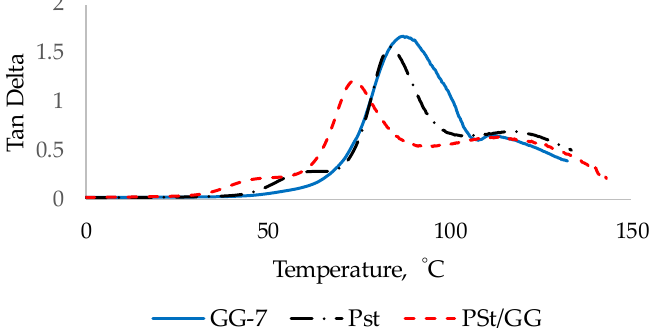
Figure 11. Tan δ of PSt-VBzGG-7 SIPN (GG-7, solid blue trace), PSt (black trace), and PSt/GG mixture Figure 11. Tan δ of PSt -VBzGG-7 SIPN (GG-7, solid blue trace), PSt (black trace), and PSt/GG mix- (red dotted ture (red dotted trace). Figure 11. Tan δ of PSt -VBzGG-7 SIPN (GG-7, solid blue trace), PSt (black trace), and PSt/GG mix- ture (red dotted trace). Figure 11. Tan δ of PSt -VBzGG-7 SIPN (GG-7, solid blue trace), PSt (black trace), and PSt/GG mix- ture (red dotted trace).